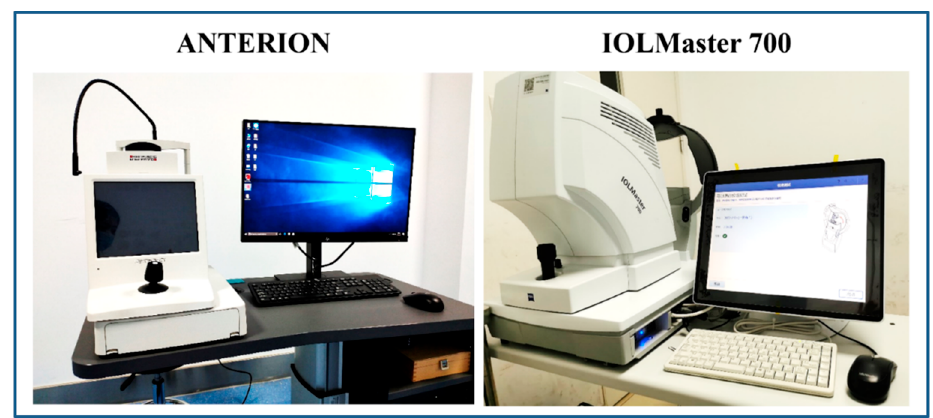
Figure 1. The two devices used in this